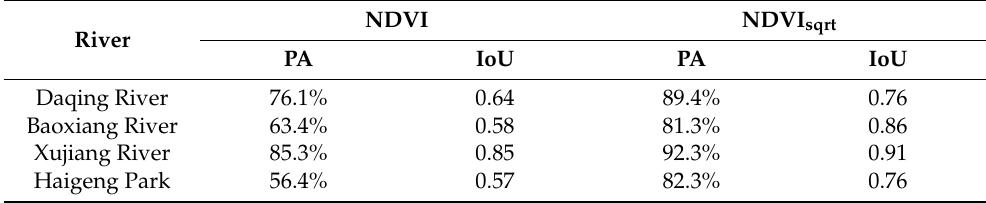
Table 3. Comparison of the performance of different feature-extraction methods for the detection of cyanobacterial blooms in typical river